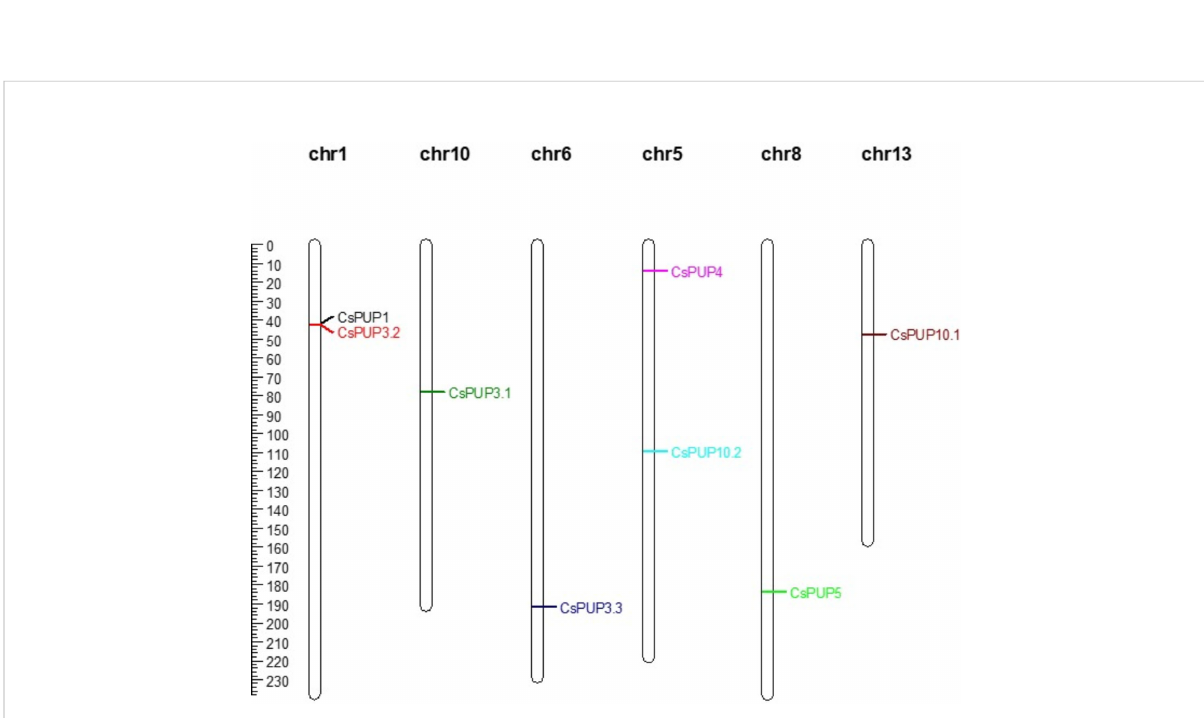
FIGURE 3 Distribution of the CsPUPs genes on chromosomes.